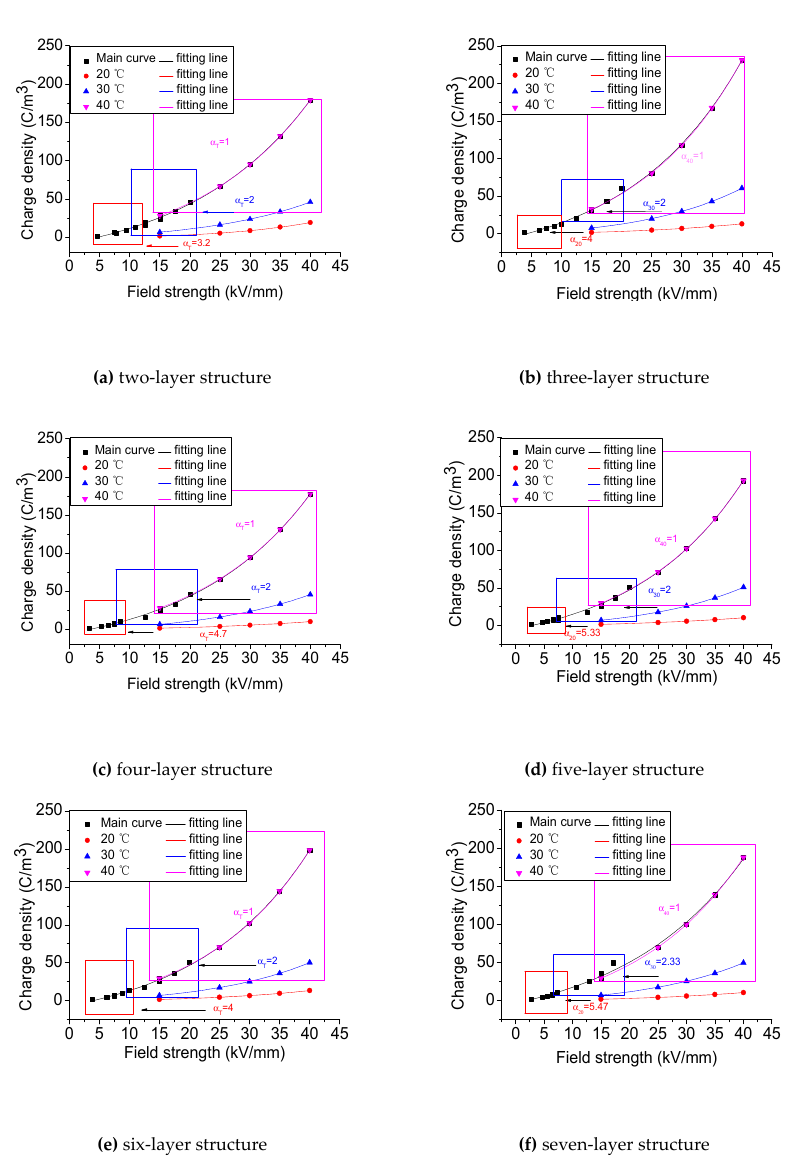
Figure 12. Interface charge density absolute values at steady state under different electrical field strengths with different temperatures.